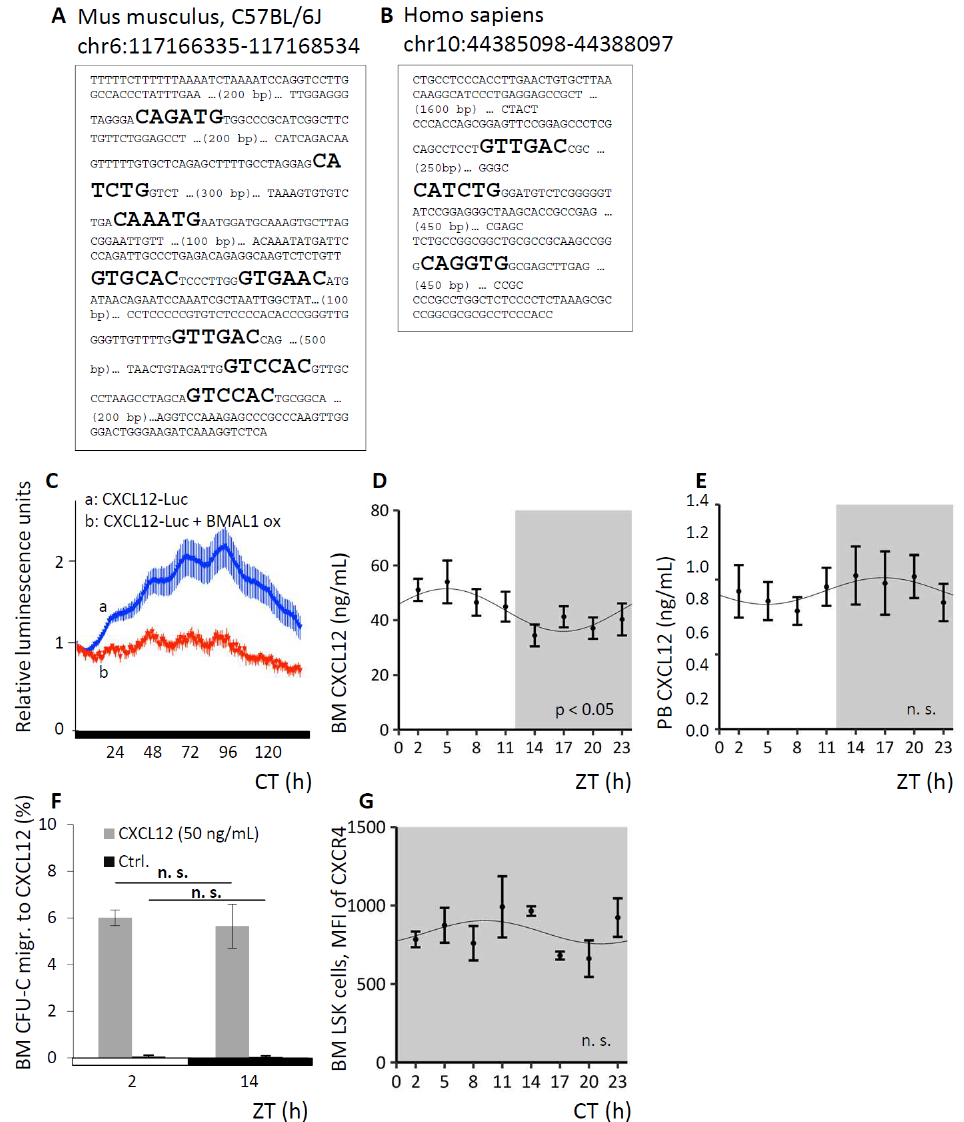
Figure 5. Circadian regulation of CXCL12. A, B. In silico analyses identified 8 E-boxes in the murine ( A ) and 3 E-boxes in the human CXCl12 promoter ( B ). C. Luciferase expression in NIH3T3 cells under